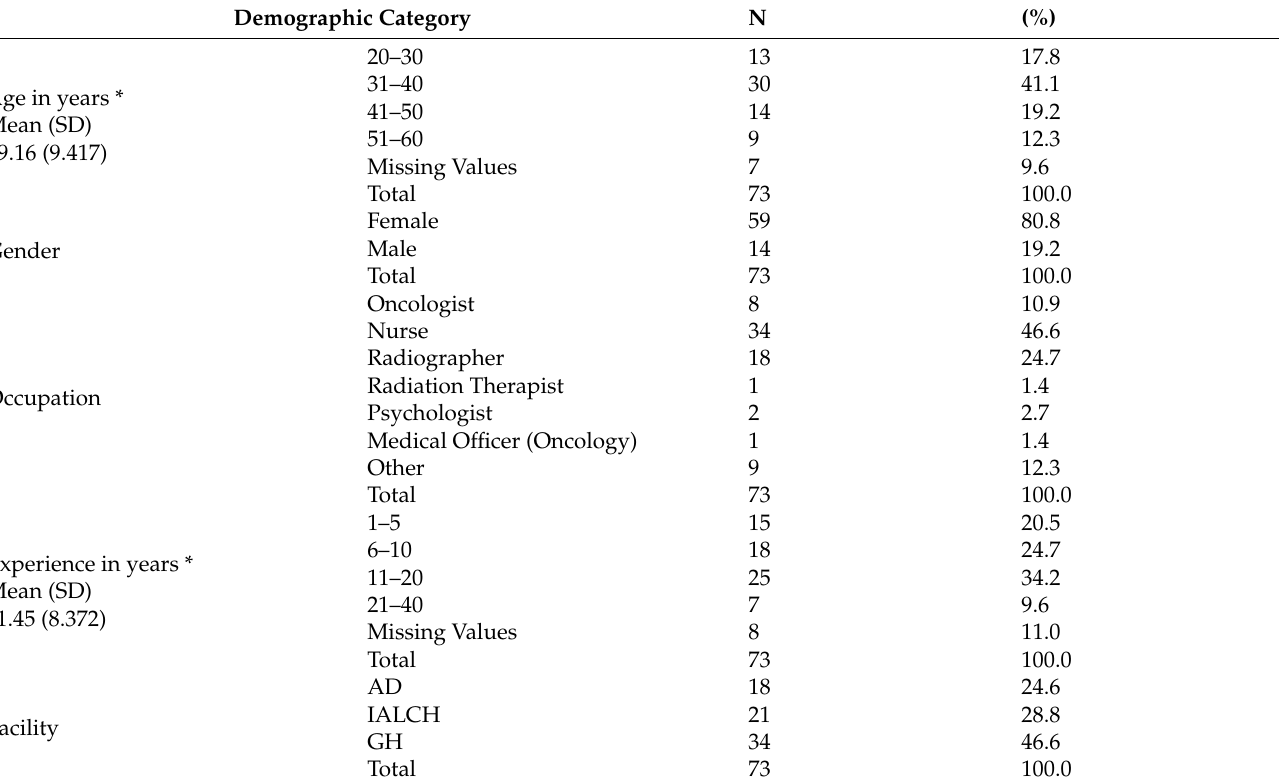
Table 1. Demographic Characteristics of the Participants from the Three Public Healthcare